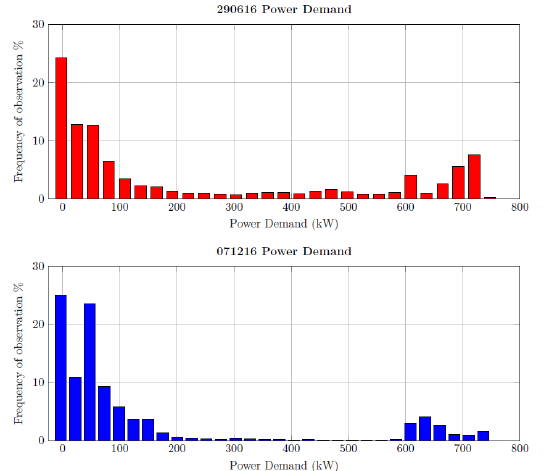
Figure 14. Power demand histogram for 29.06.16 and 07.12.16 datasets.